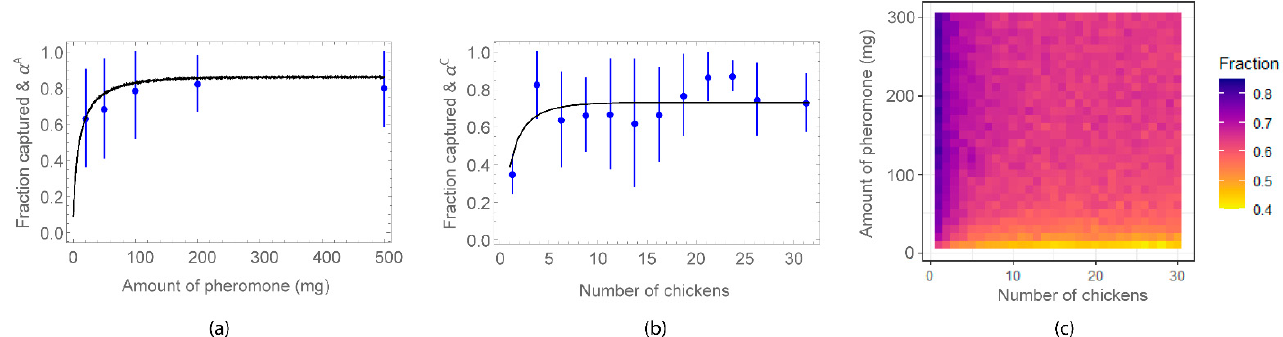
Figure 2. Proportions of Lu. longipalpis as a function of: ( a ) amount of pheromone (for the experiment A ); ( b ) number of chickens (for the experiment C ); ( c ) amount of pheromone and number of chickens (simulation results). Measured mean and standard deviation are shown in blue and fitted curves in black in ( a ) and ( b ).